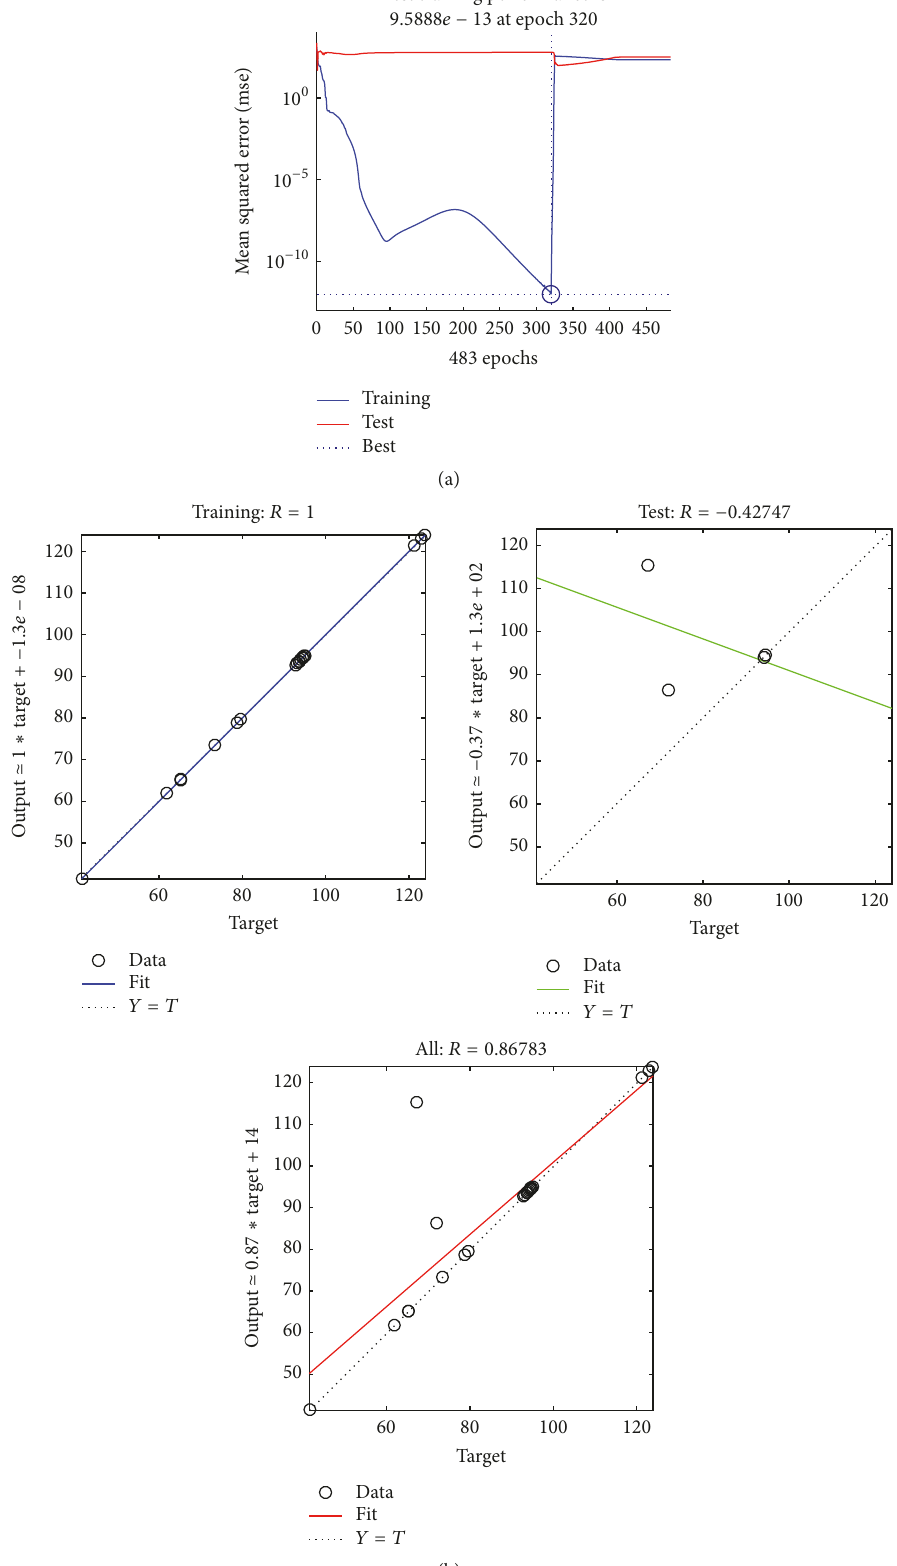
Figure 7: (a) ANN regression performance for M1; (b) regression